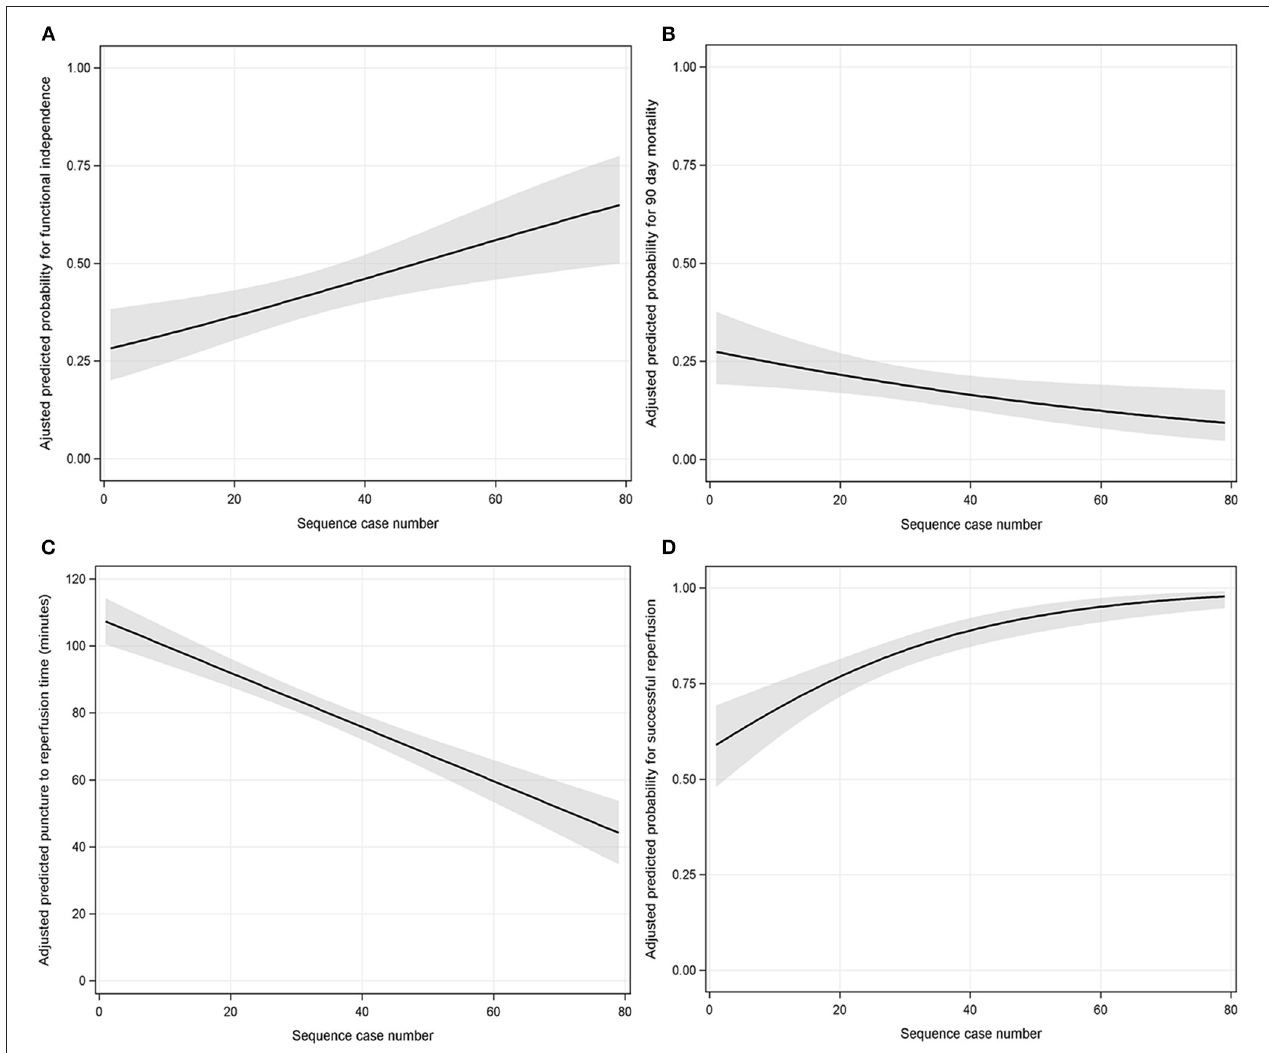
FIGURE 2 | The association between procedural experience and outcomes ( A = functional independence; B = 90-days mortality; C = puncture-to-reperfusion time; D = successful reperfusion). The black line with shaded bands represents the adjusted predicted curve with 95% confidence interval.